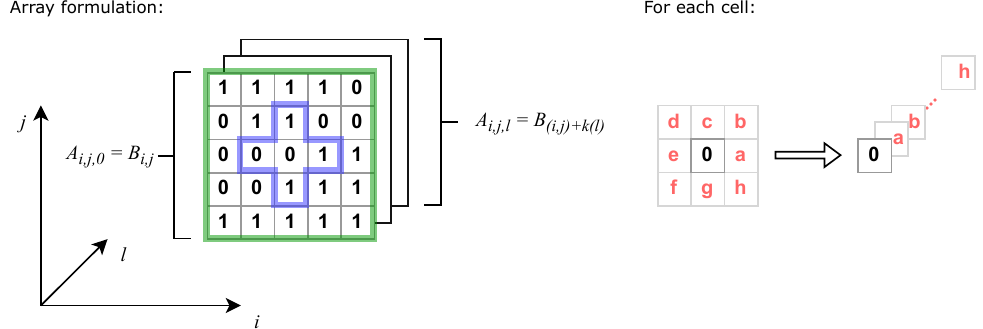
Figure 4. Schematic example of a three-dimensional array A . It contains the irradiation array B along the axes i and j . Along the third axis l the copies of B are arranged, each of them displaced according to a relative indexing k ( l ) that corresponds to one of the neighbourhood positions. The two neighbourhood concepts employed, M OORE and V ON N EUMANN , are represented by green and blue highlightings in the array on the left side,